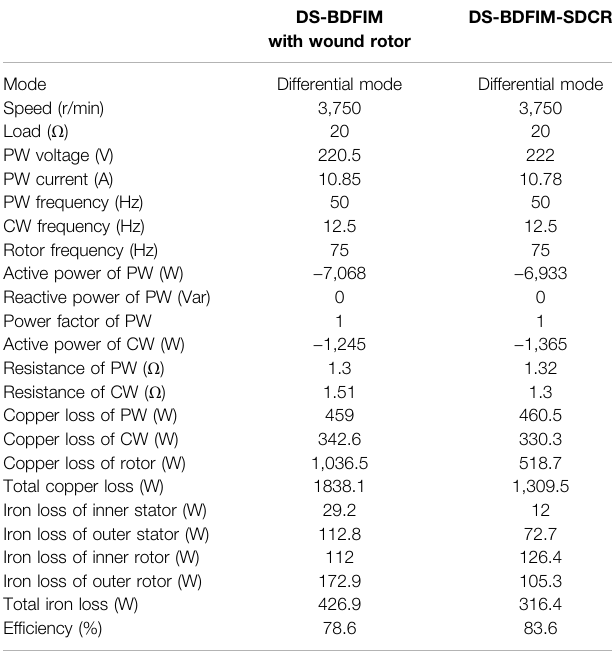
TABLE 5 | Performance comparison between DS-BDFIM-SDCR and DS-BDFIM with wound rotor.